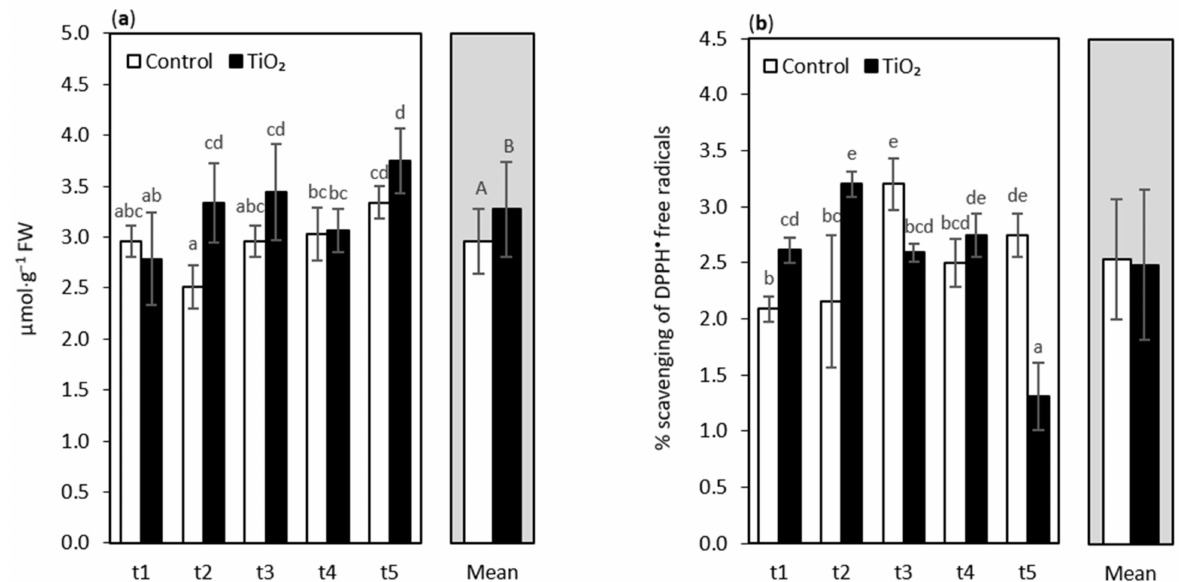
Figure 1. Malondialdehyde (MDA) content ( a ) and total antioxidant capacity (TAC) expressed as % scavenging of DPPH • free radicals ( b ) of oakleaf lettuce seedlings treated with TiO 2 -NPs applied on the leaves as a 0.75% suspension, while the control plants were sprayed with deionized water. Plants were sampled at 4, 7, 9, 11, and 13 days after treatment (sampling time: t1, . . . , t5, respectively). Lower-case letters above bars highlight the significant differences for interaction effects, and capital letters indicate the differences between the means for the treatment groups (NPs treated plants and control plants), according to Fisher’s test ( p ≤ 0.05). Missing letters indicate no significant differences. Error bars represent standard deviations ( ±